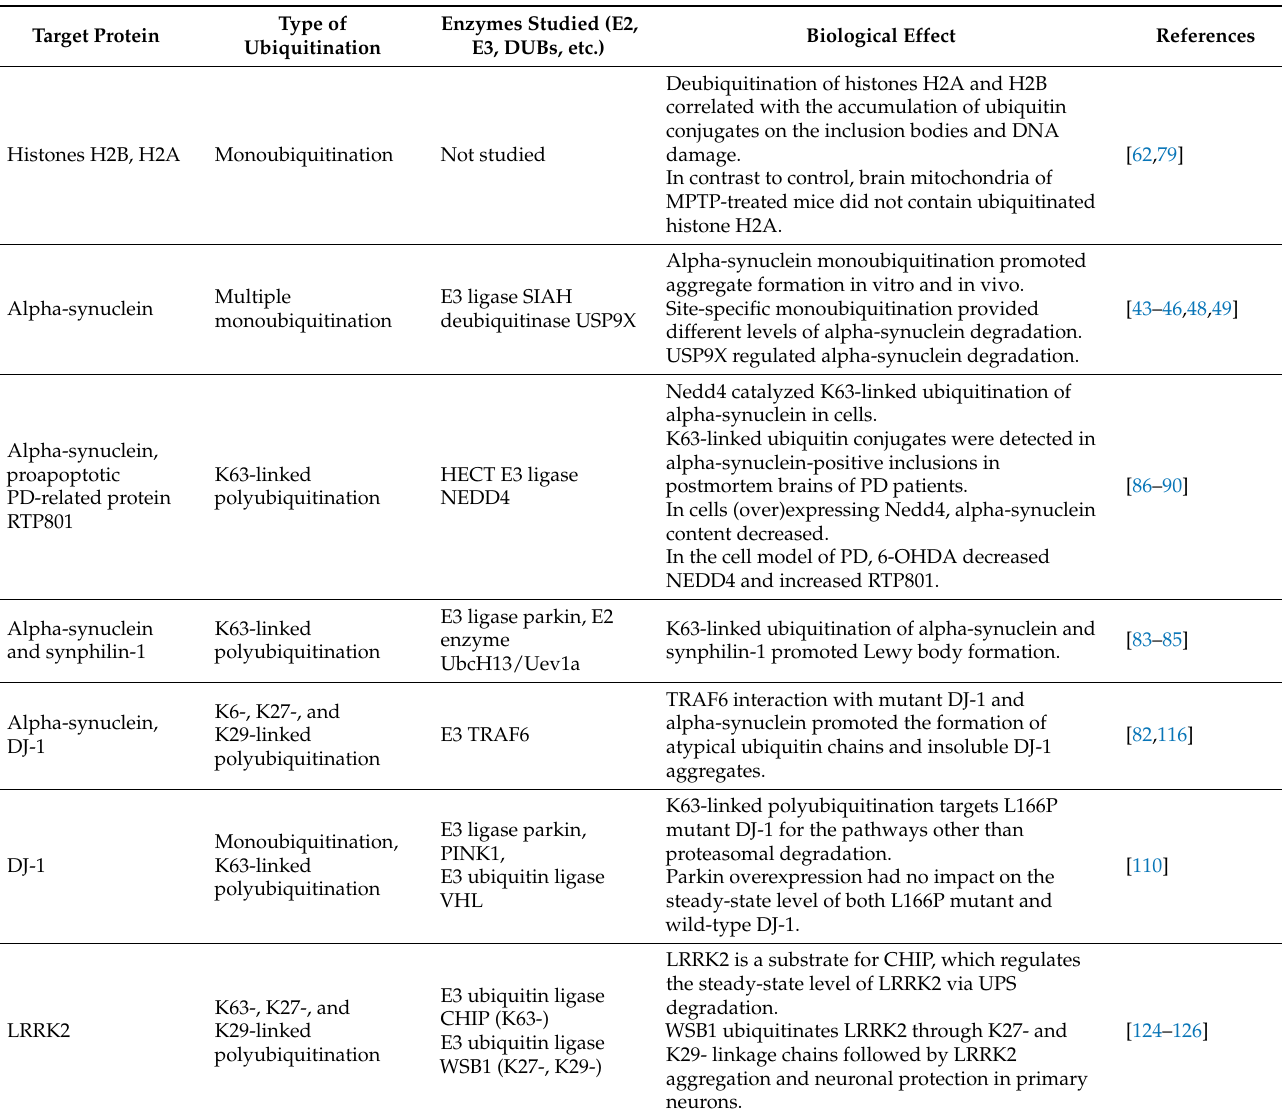
Table 2. Atypical ubiquitination of proteins in PD and PD-related